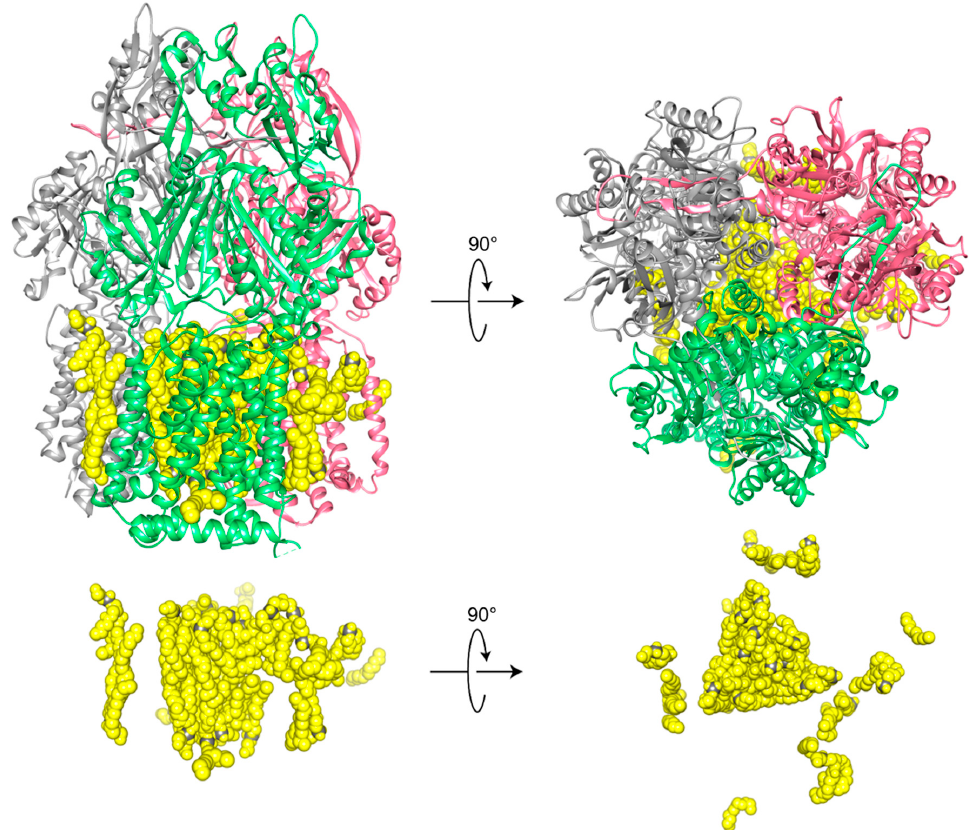
Figure 3. Top and side views of high resolution cryo-EM structure of trimeric wild-type AcrB (gray, green, pink subunits) and associated lipids (yellow) in SMA2000 nanodiscs (EMD-7074, PDB ID 6BAJ) [45]. The central cavity is filled with 24 triangular-like core